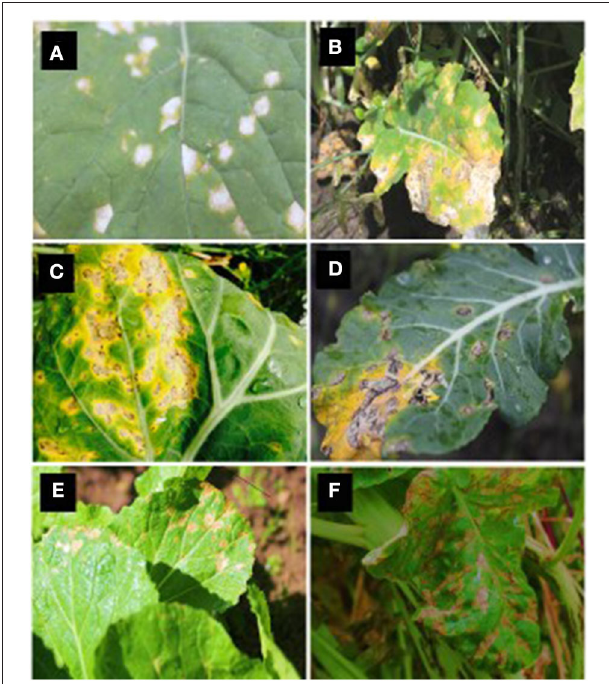
FIGURE 3 | White leaf spot symptoms caused by Neopseudocercosporella capsellae on different hosts. Leaf lesions on oilseed rape: Brassica napus (A) and B. juncea (B) , vegetable brassicas: B. oleracea var. capitata (cabbage - C ), B. oleracea var. italica (broccoli - D ), B. campestris var . chinensis (Chinese cabbage - E ), and Raphanus sativus (radish - F ).